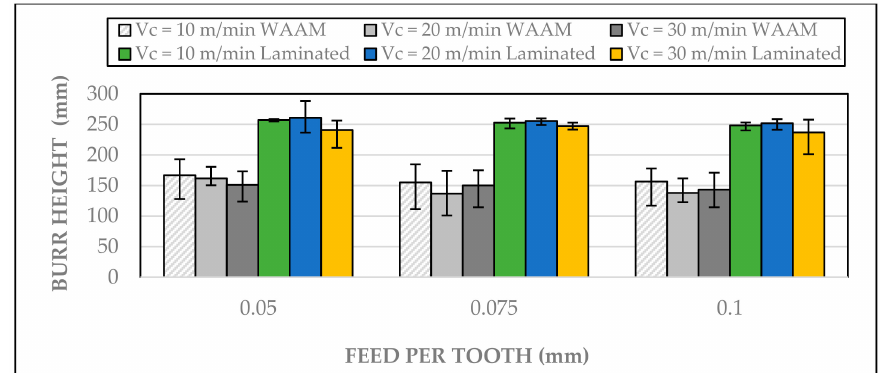
Figure 15. E ff ect of the cutting parameters and material manufacturing process on the burr